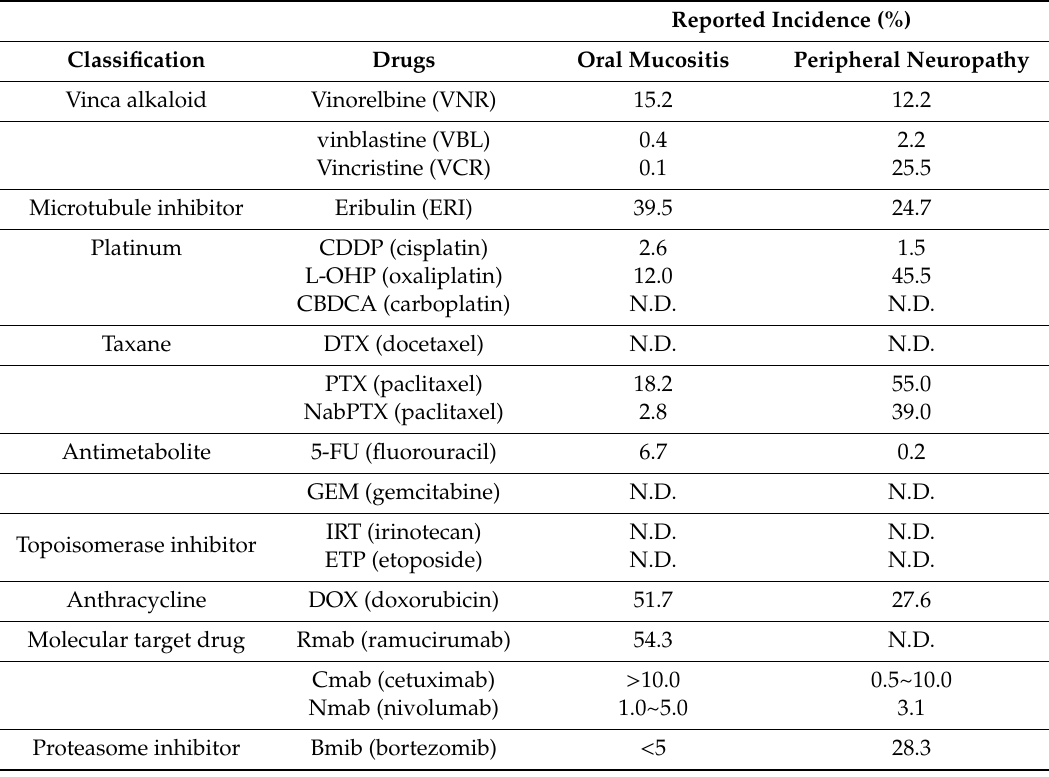
Table 1. Incidence of oral mucositis and peripheral neuropathy induced by anticancer